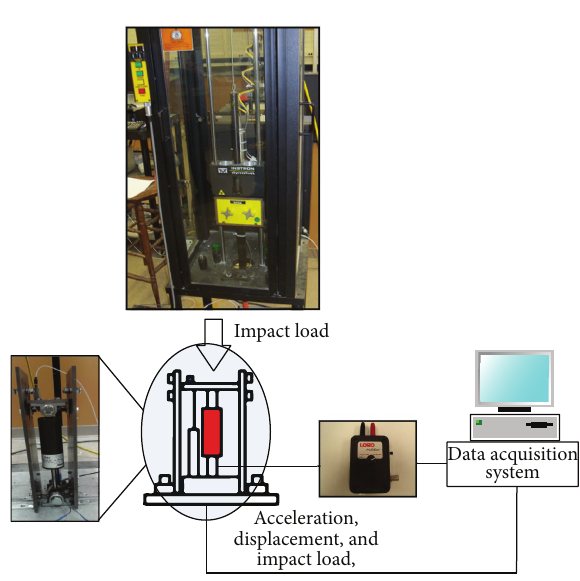
Figure 6: Details of the test